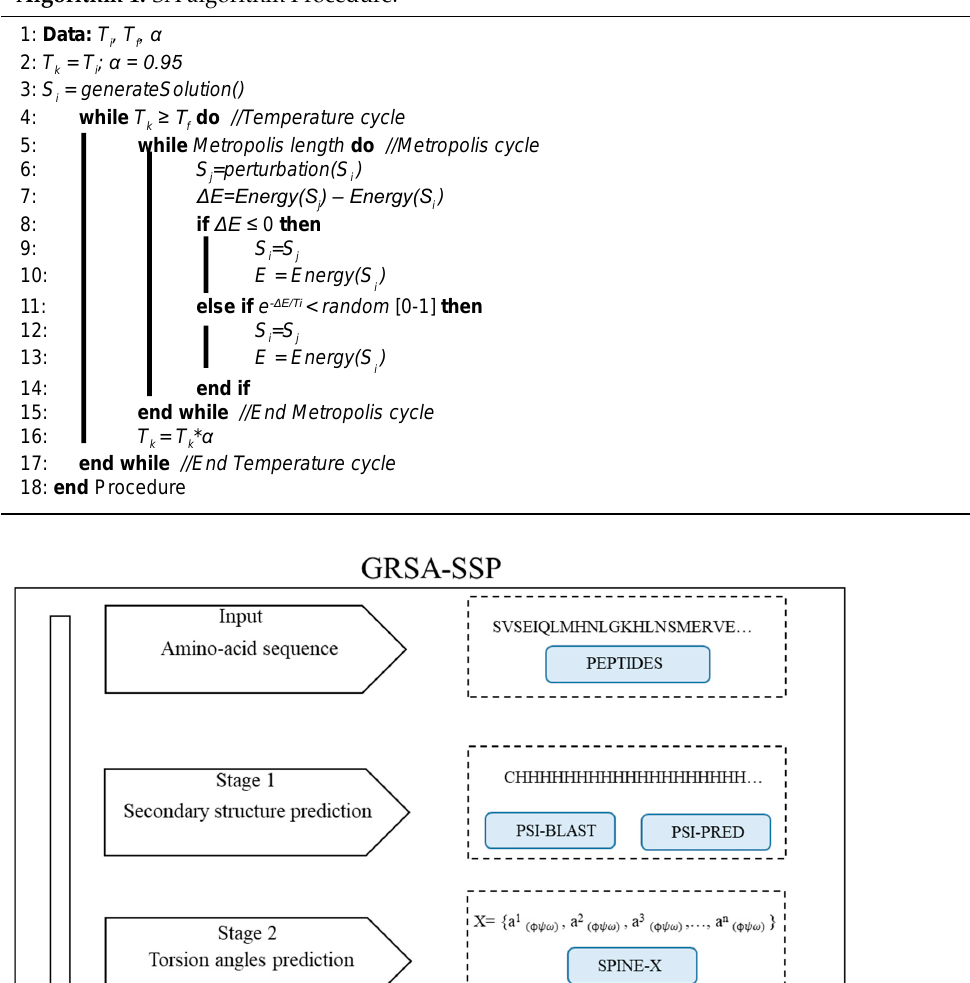
Algorithm 1. SA algorithm Procedure. Algorithm 1 SA algorithm Procedure 1: Data: T , T , α i f